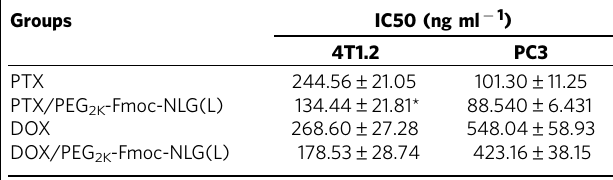
Table 2 | IC50 of PTX or DOX in different formulations.